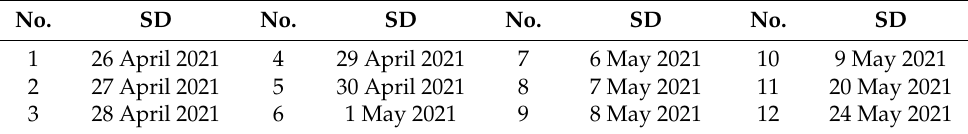
Table 1. Check list of sample numbers (No.) and sampling date (SD).